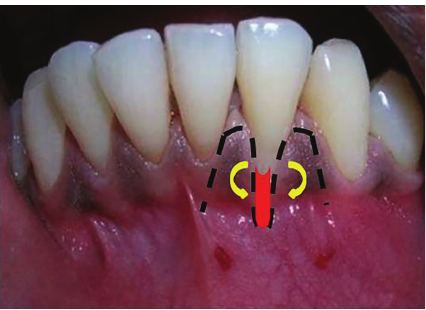
Figure 1: Preoperative photograph showing recession in relation to 32.